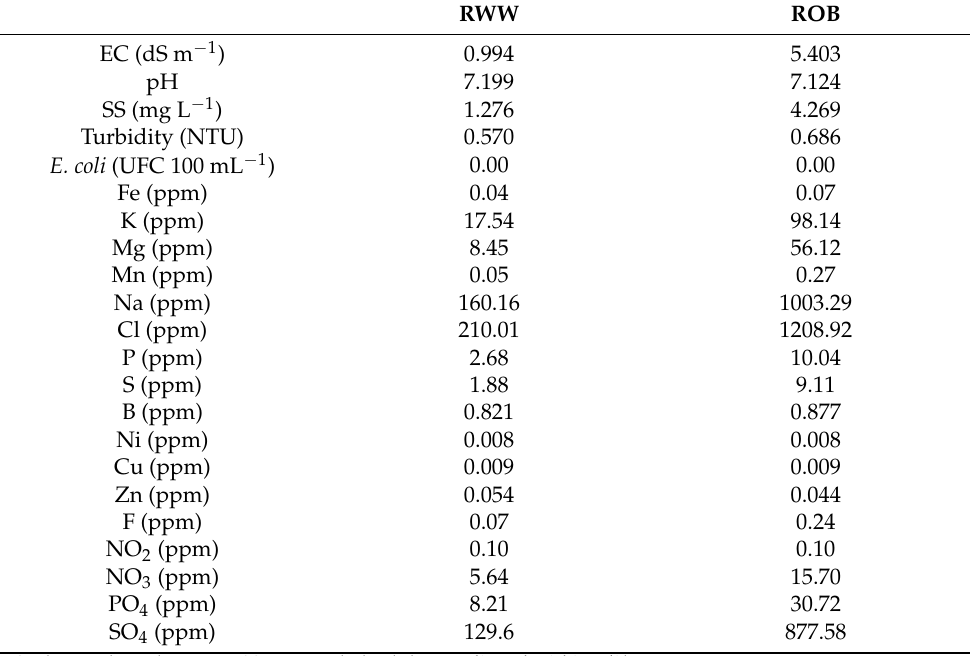
Table 1. Physicochemical analyses of the irrigation treatments. Data is presented as average values of the water samples collected during the experiment.